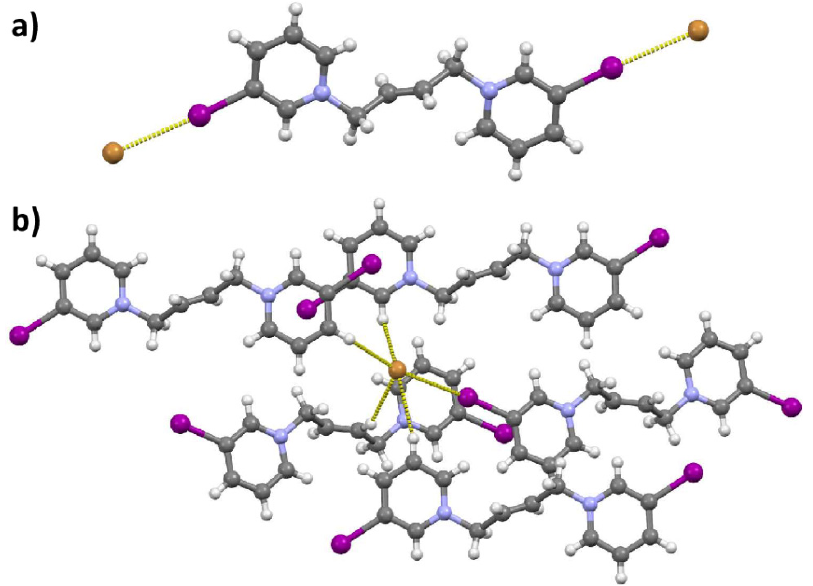
Figure 7. ( a ) One [ N , N ′ - Buen -( 3-IPy ) 2 ] 2+ cation binds two bromide anions by C − I ⋯ Br − halogen bonds in the structure of [ N , N ′ - Buen -( 3-IPy ) 2 ]Br 2 ; ( b ) Bromide anion binds four neighbouring cations through C − H ⋯ Br − and one cation through C − I ⋯ Br − halogen bonds leading to formation of a 3D structure.